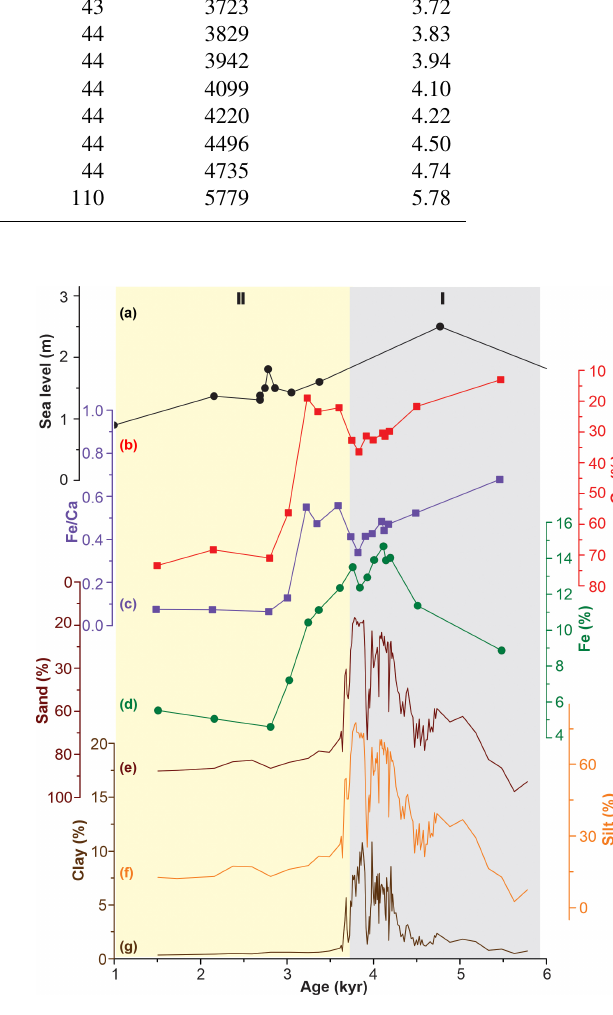
Figure 3. Comparison between sea level changes with sedimento- logic records over the past 6kyr. (a) Sea level (m) (Castro et al., 2014); (b) Ca (%), (c) Fe / Ca, (d) Fe (%), (e) sand (%), (f) silt (%), and (g) clay (%). The gray and yellow bars indicate two different stages in the last 6kyr, marine (I) and lacustrine (II) stages, respec-